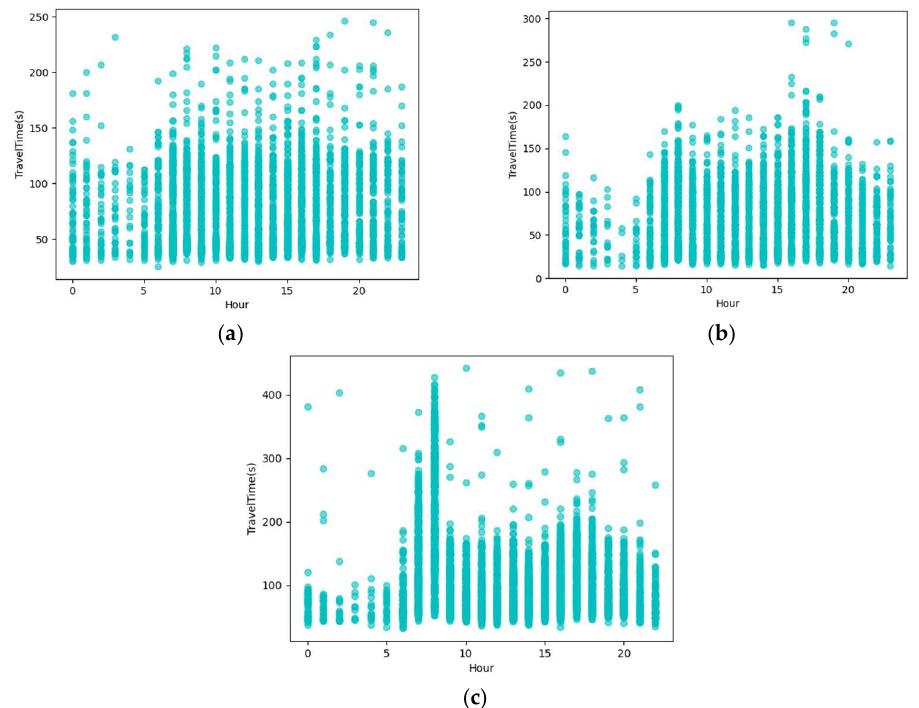
Figure 2. Hourly distribution of travel time. ( a ) Road Link 1. ( b ) Road Link 2. ( c ) Road Link 3.